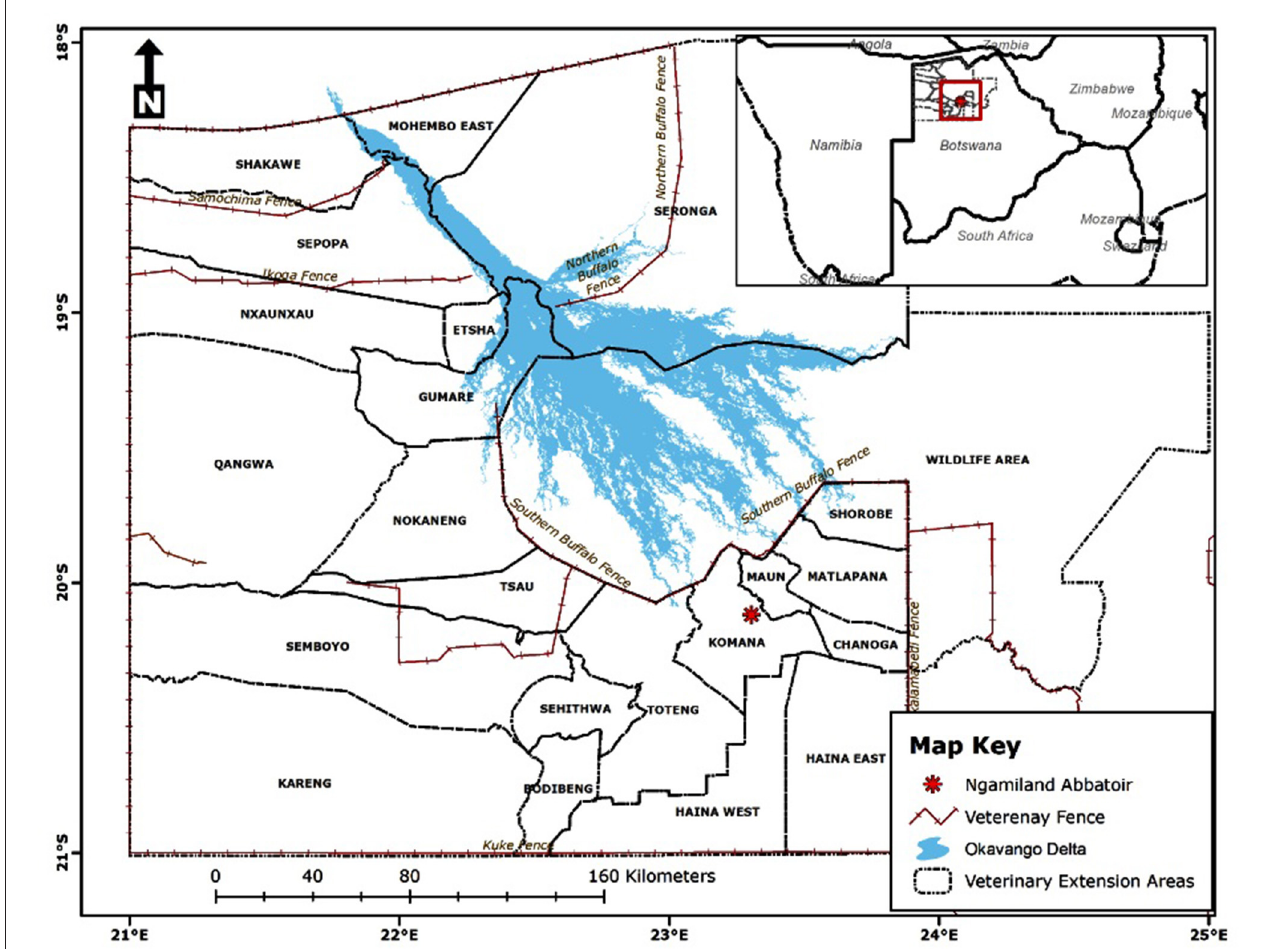
FIGURE 1 | Location of Ngamiland abattoir and catchment areas for supply of cattle for slaughter [Source: Adapted from the Department of Veterinary Services’ Veterinary Epidemiology and Economic Section (VEES), Botswana,